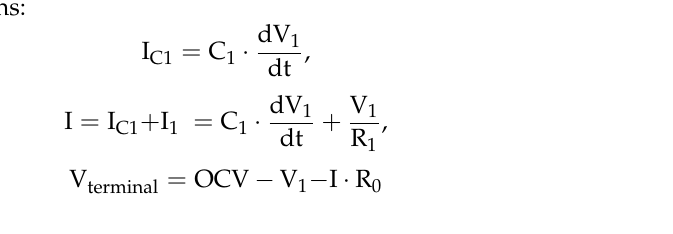
Figure 8. Battery cell model with 1 RC branch and thermal dependence.